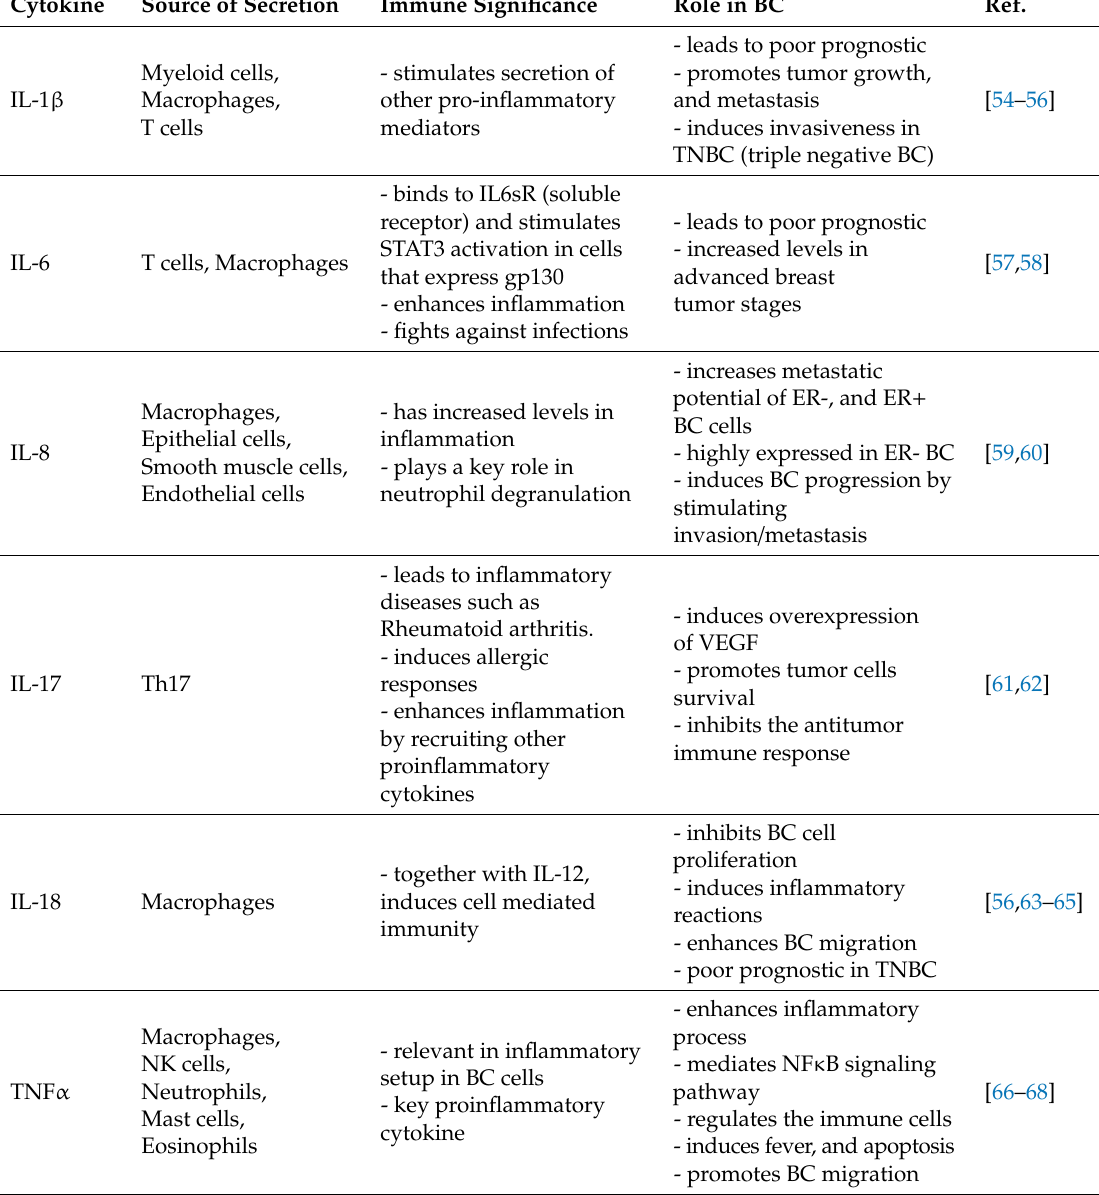
Table 1. Proinflammatory cytokines involved in tissue inflammation and Breast Cancer (BC) development.